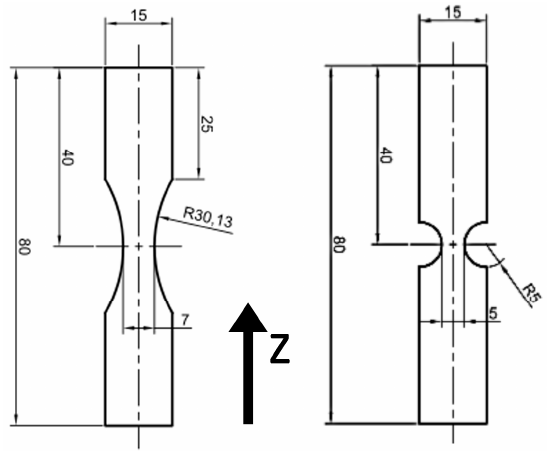
Figure 1. Geometries of smooth and circular notched specimens and built axis (Z) (dimensions in mm).